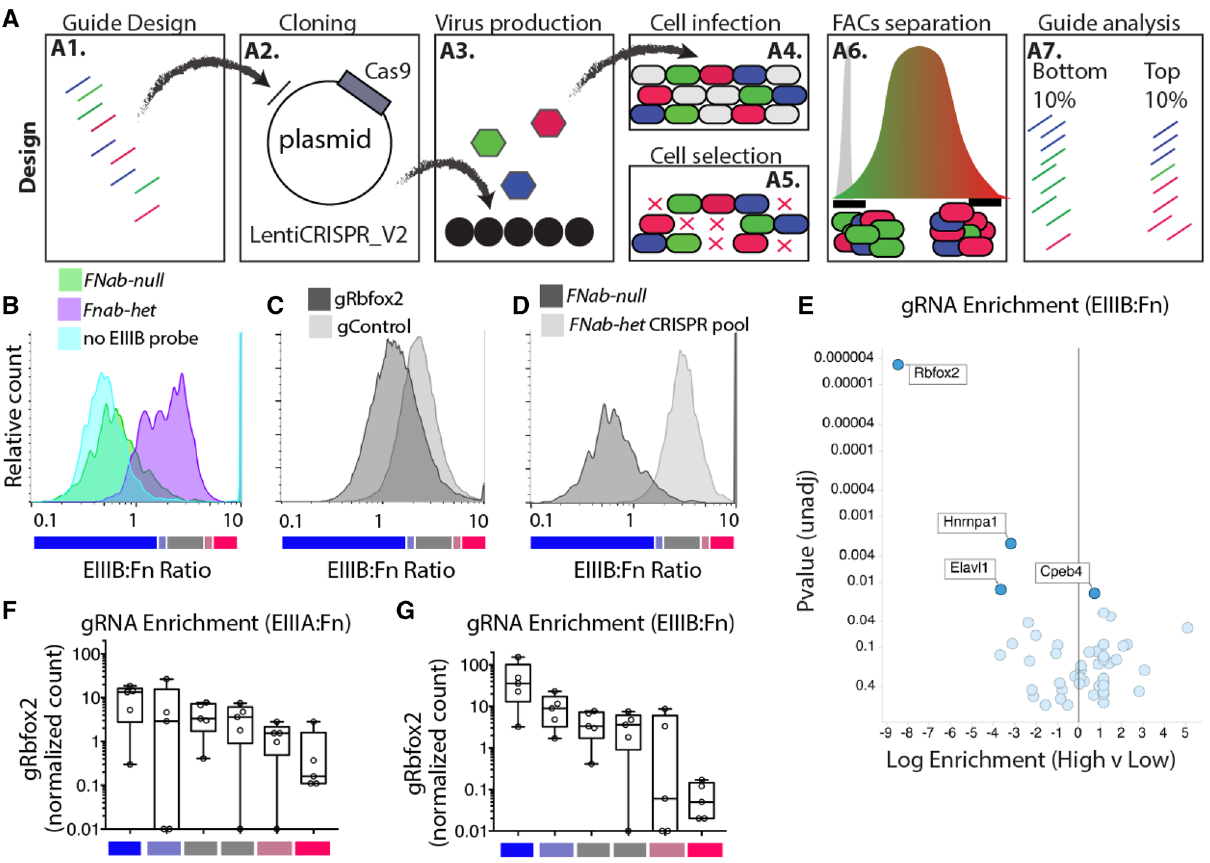
Figure 2. Application of CRISPR screening approach to define regulators of EIIIIA and EIIIB inclusion. ( A ) Screening approach (A1) Guides to each target gene of interest were designed using the latest rules in the Broad design tool, and prepared as an ssDNA oligo pool. Low-cycle PCR generates dsDNA with ligation sites for (A2) batch cloning into a lentiviral backbone containing Cas9 and guide expression site. (A3) The resultant plasmid library is then used for production of lentivirus and infection of cells (A4). Infection is at 0.3 MOI and (A5) selection is by puromycin. (A6) Selected cells are sorted on the inclusion of alternative exon. Cells in the top 10% and bottom 10% of the response are isolated. (A7) Genomic DNA is isolated and guide enrichment in cells is assessed by sequencing of amplified lentiviral insertions. ( B–D ) Ratio of EIIIB to Fn probes, showing cells with and without EIIIB or no EIIIB probe at all ( B ), a guide targeting Rbfox2 (gRbfox2) or a control guide (gControl) ( C ) and the pool of CRISPR guides targeting all 57 splice factors ( D ). ( E ) Volcano plot showing the enrichment of guides for the indicated genes among cells with high levels of EIIIB inclusion versus low levels of EIIIB inclusion. Log enrichment and p-value is from MaGeCK analysis. ( F,G ) Plots showing the normalized count for individual guides targeting Rbfox2 in each sorted group of cells. Low, mid, or high levels of EIIIA and EIIIB inclusion are shown and represent the bins shown in ( B–D